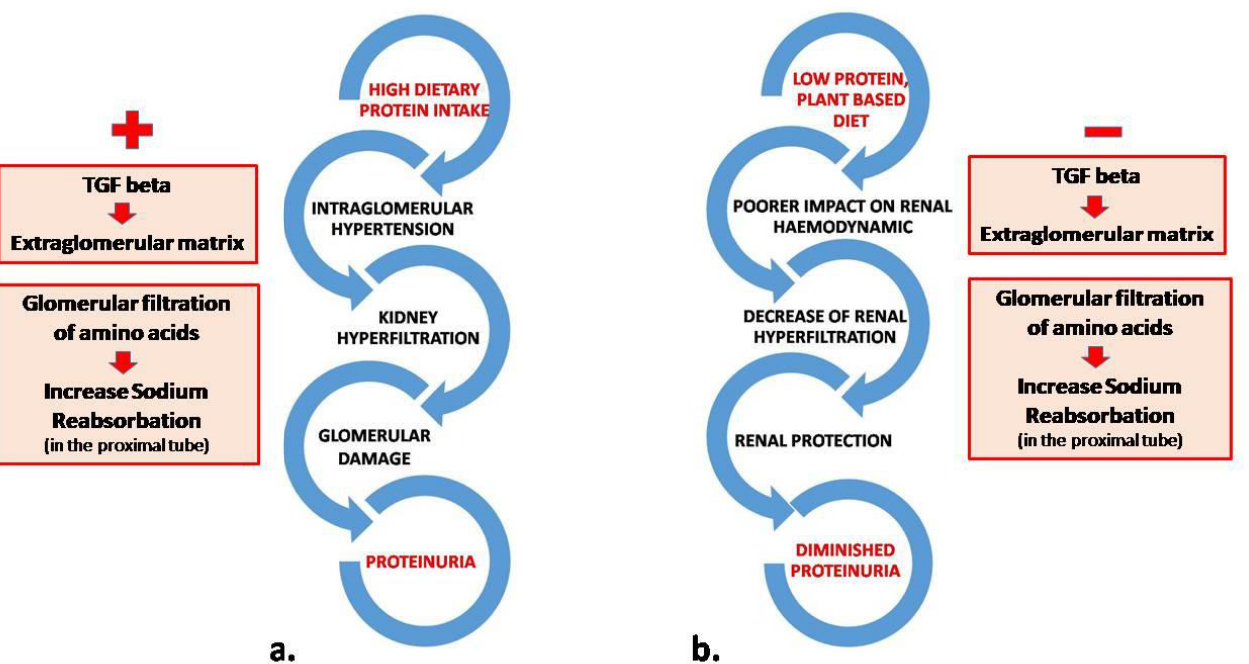
Figure 1. Mechanistic model associating dietary interventions and reduction of proteinuria. High dietary protein intake ( a ) leads to intraglomerular hypertension eliciting high levels of TGF-beta and subsequent accumulation of extraglomerular matrix with the development of fibrosis. During a low protein diet ( b ), renal hemodynamics is preserved and fibrosis TGF beta-mediated is avoided.